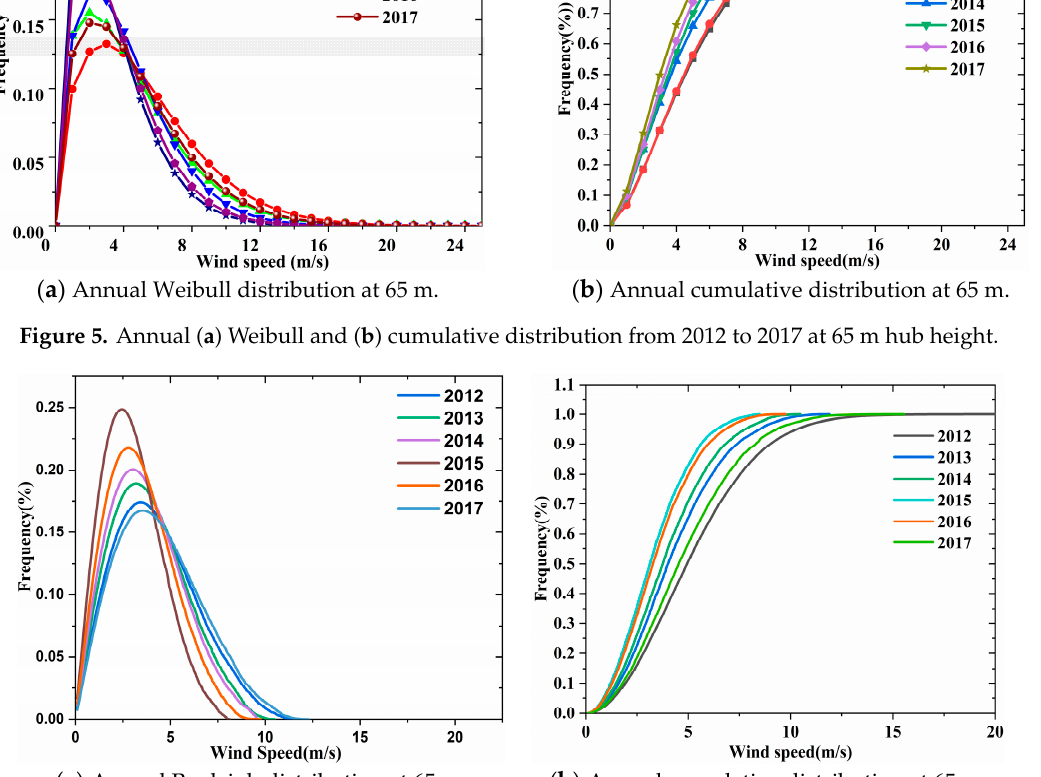
Figure 6. Annual ( a ) Rayleigh and ( b ) cumulative distribution from 2012 to 2017 at 65 m hub height.